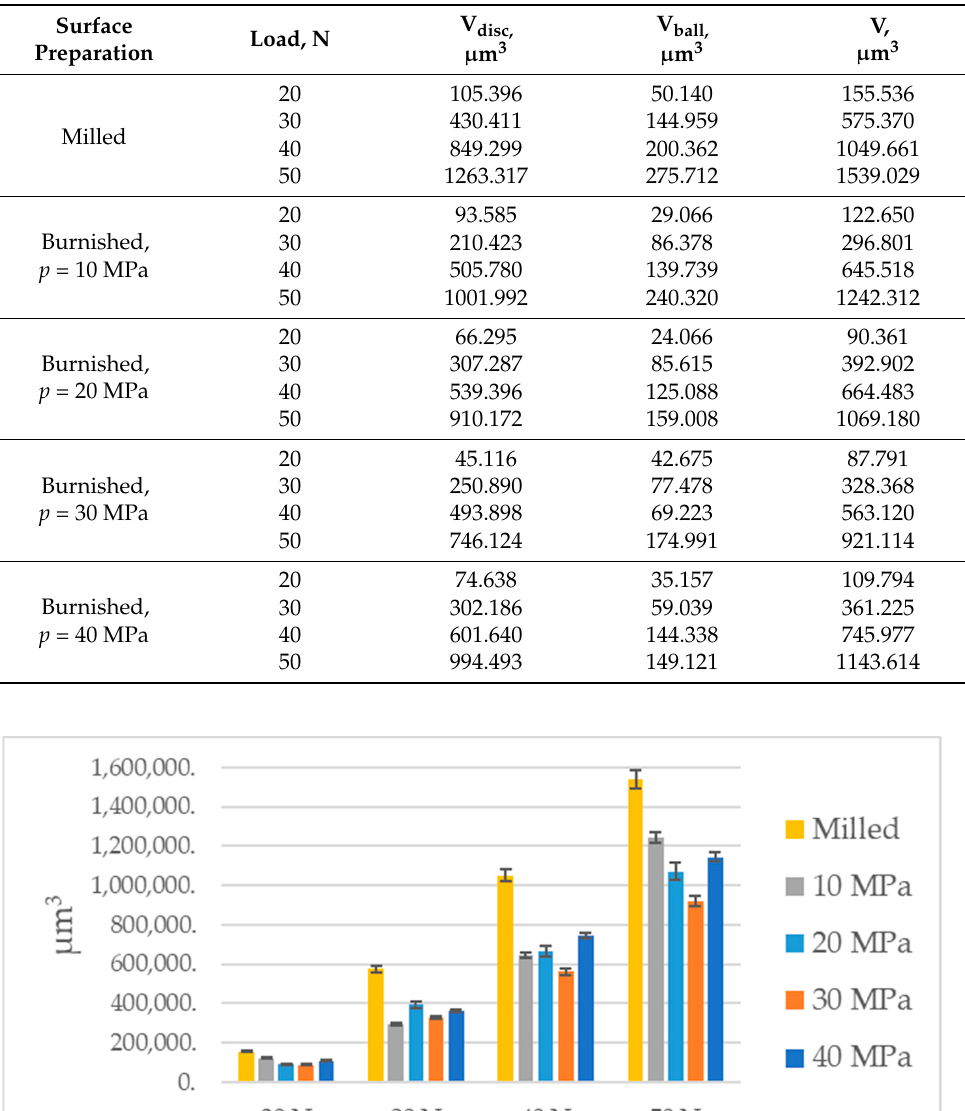
Table 2. The values of volumetric wear of disc V disc , of balls V ball, and of tribological system V. Surface Preparation